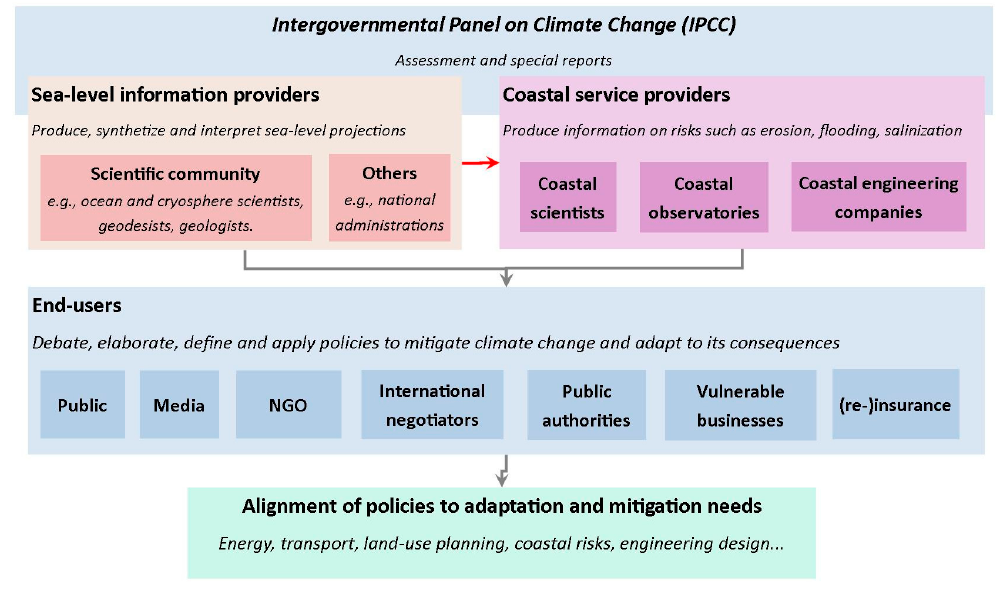
Figure 2. Current interactions between users and producers of sea level projections. Arrows denote information flows involving sea level projections or derived products.